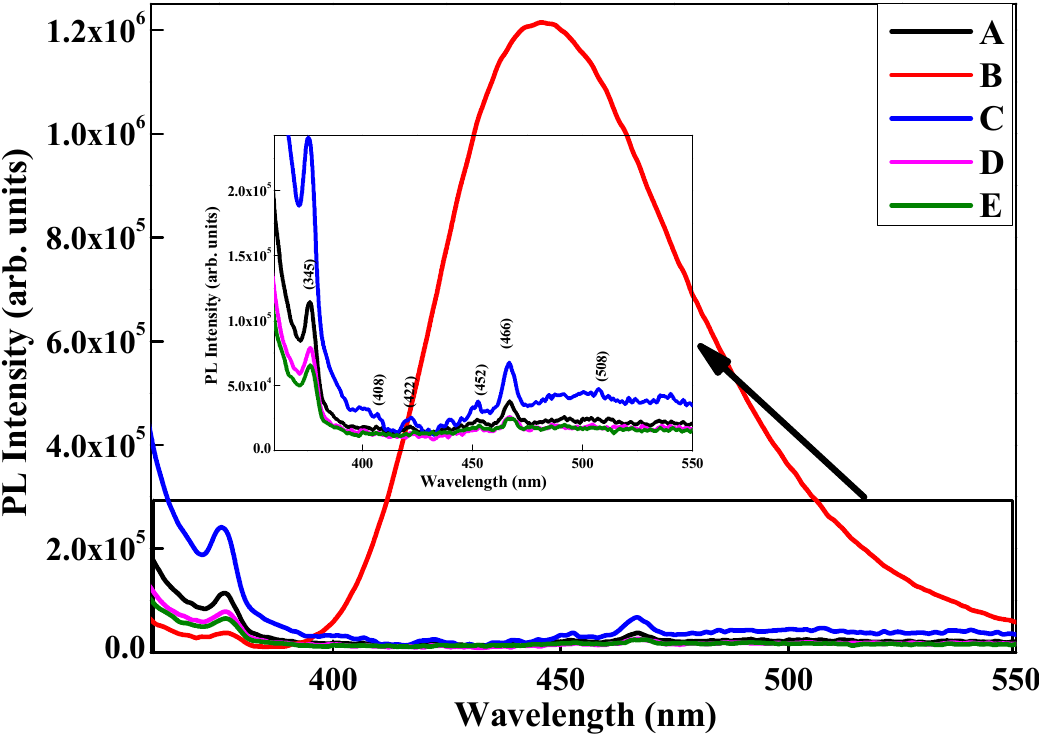
Figure 9. Emission spectra of different NiO samples excited at 308 nm. Table 2. Oxidation potential ( E O ), reduction potential ( E R ) and the di ff erence between E O and E R of di ff erent NiO